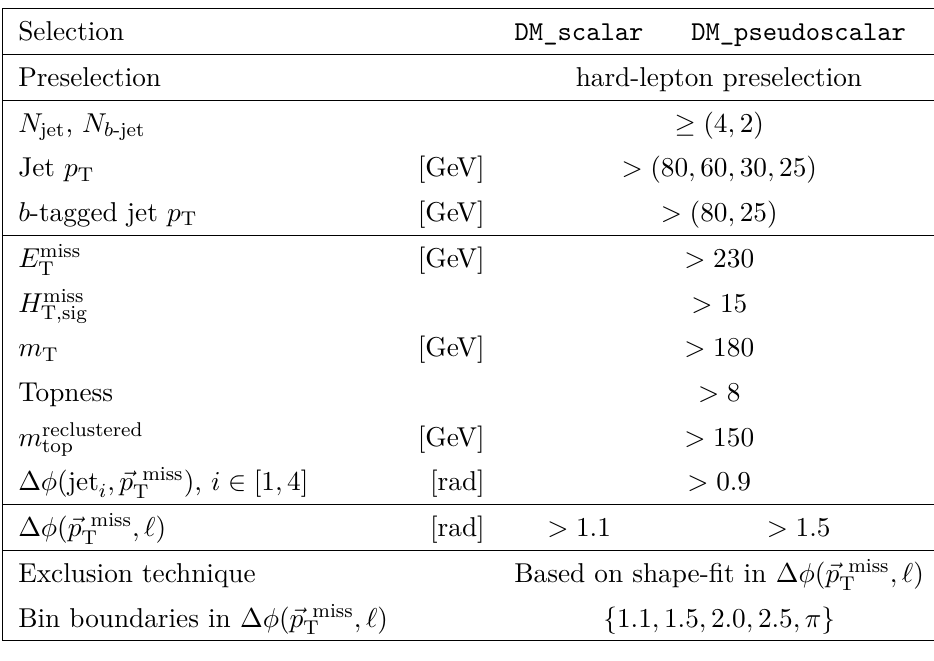
Table 8. Event selections defining the DM signal